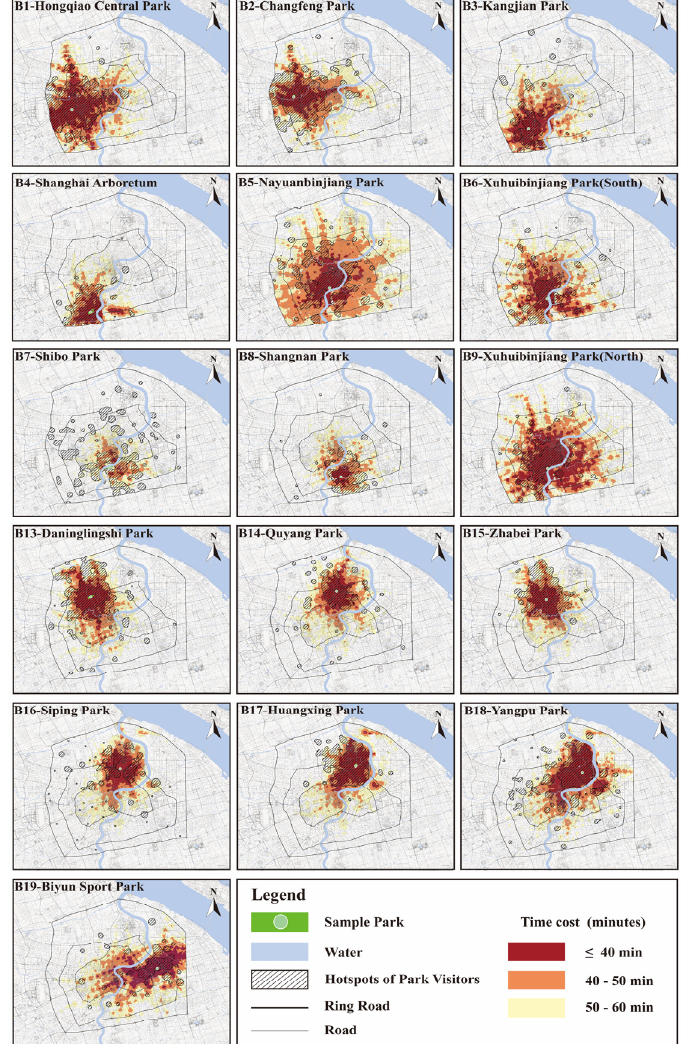
Figure A1. Comparative analysis between park service area and accessibility (Category B).